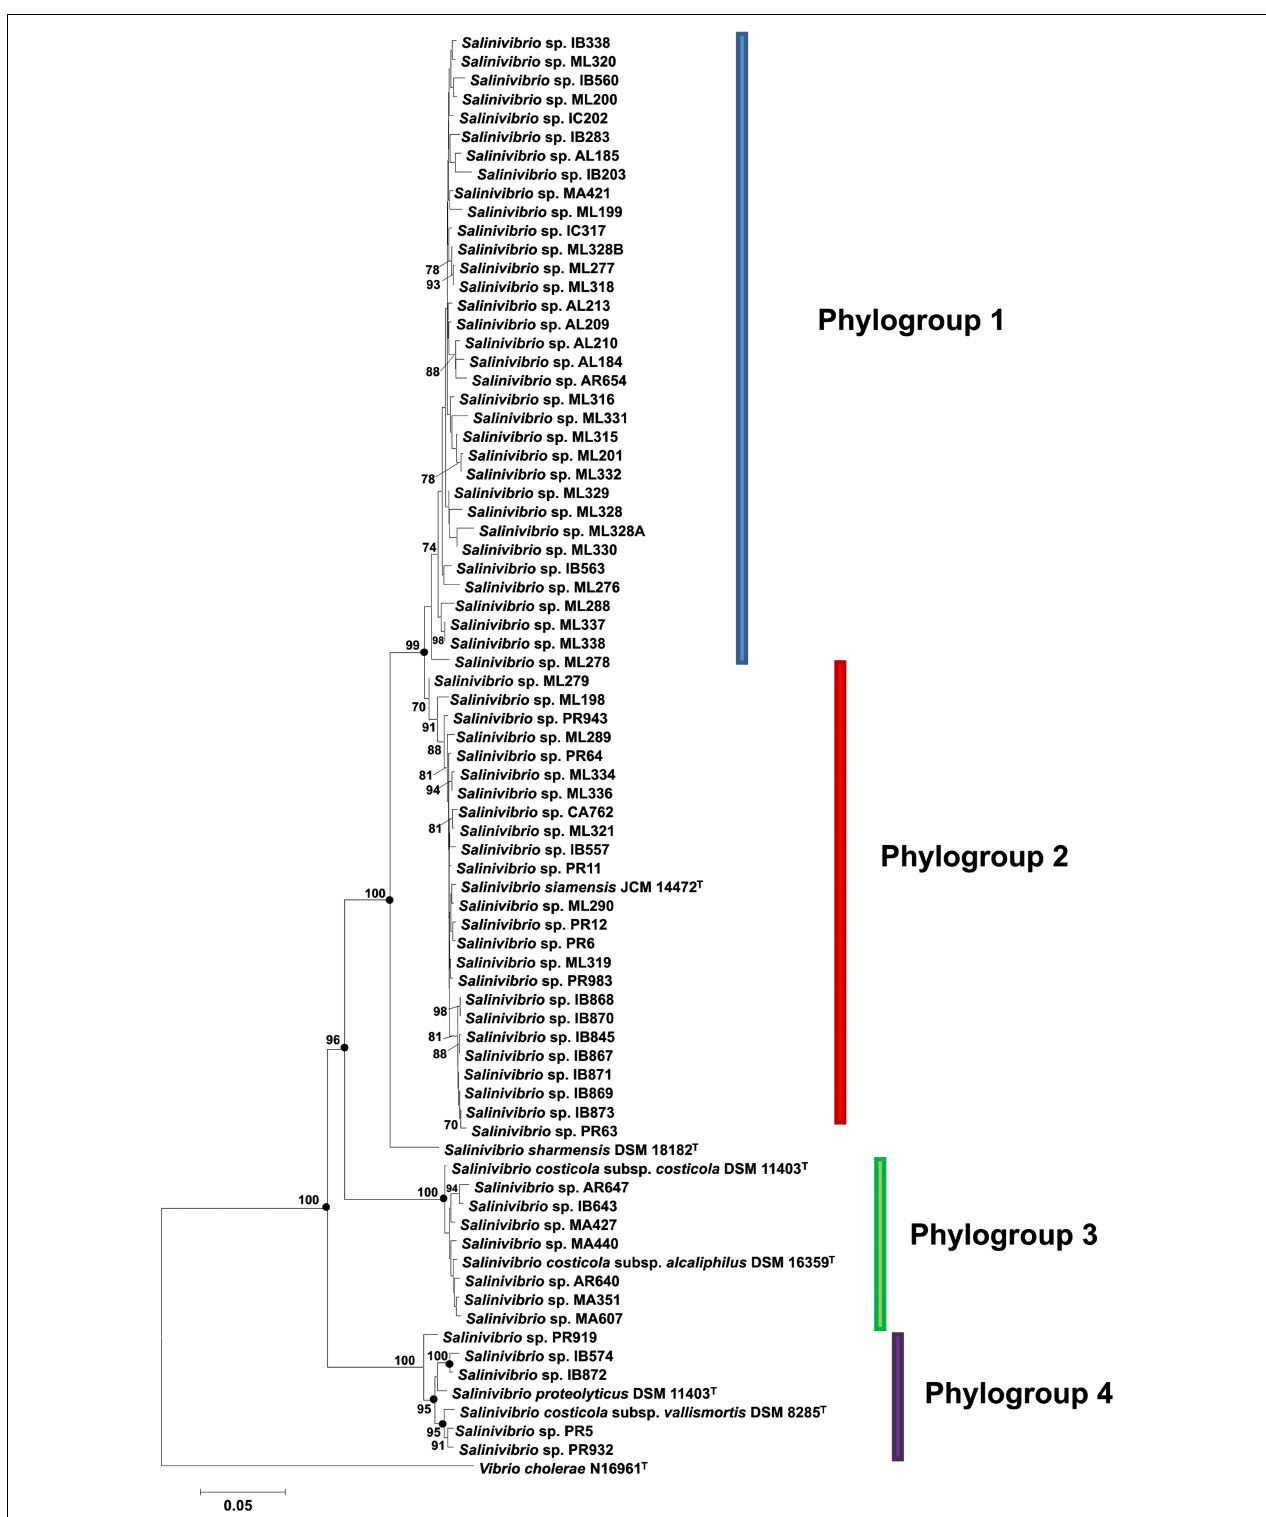
FIGURE 2 | Phylogenetic reconstruction of Salinivibrio strains based on concatenated gyrB , recA , rpoA, and rpoD gene sequences. The tree is based on 2981 nt of common sequence. Analysis was done using the neighbor-joining method. Circles indicate branches that were supported by NJ, MP and ML algorithms. Only bootstrap values above 70% are shown (1000 replications) at branches points. Bar, 0.05 expected nucleotide substitutions per site. V. cholerae N16961 T was used as an outgroup.